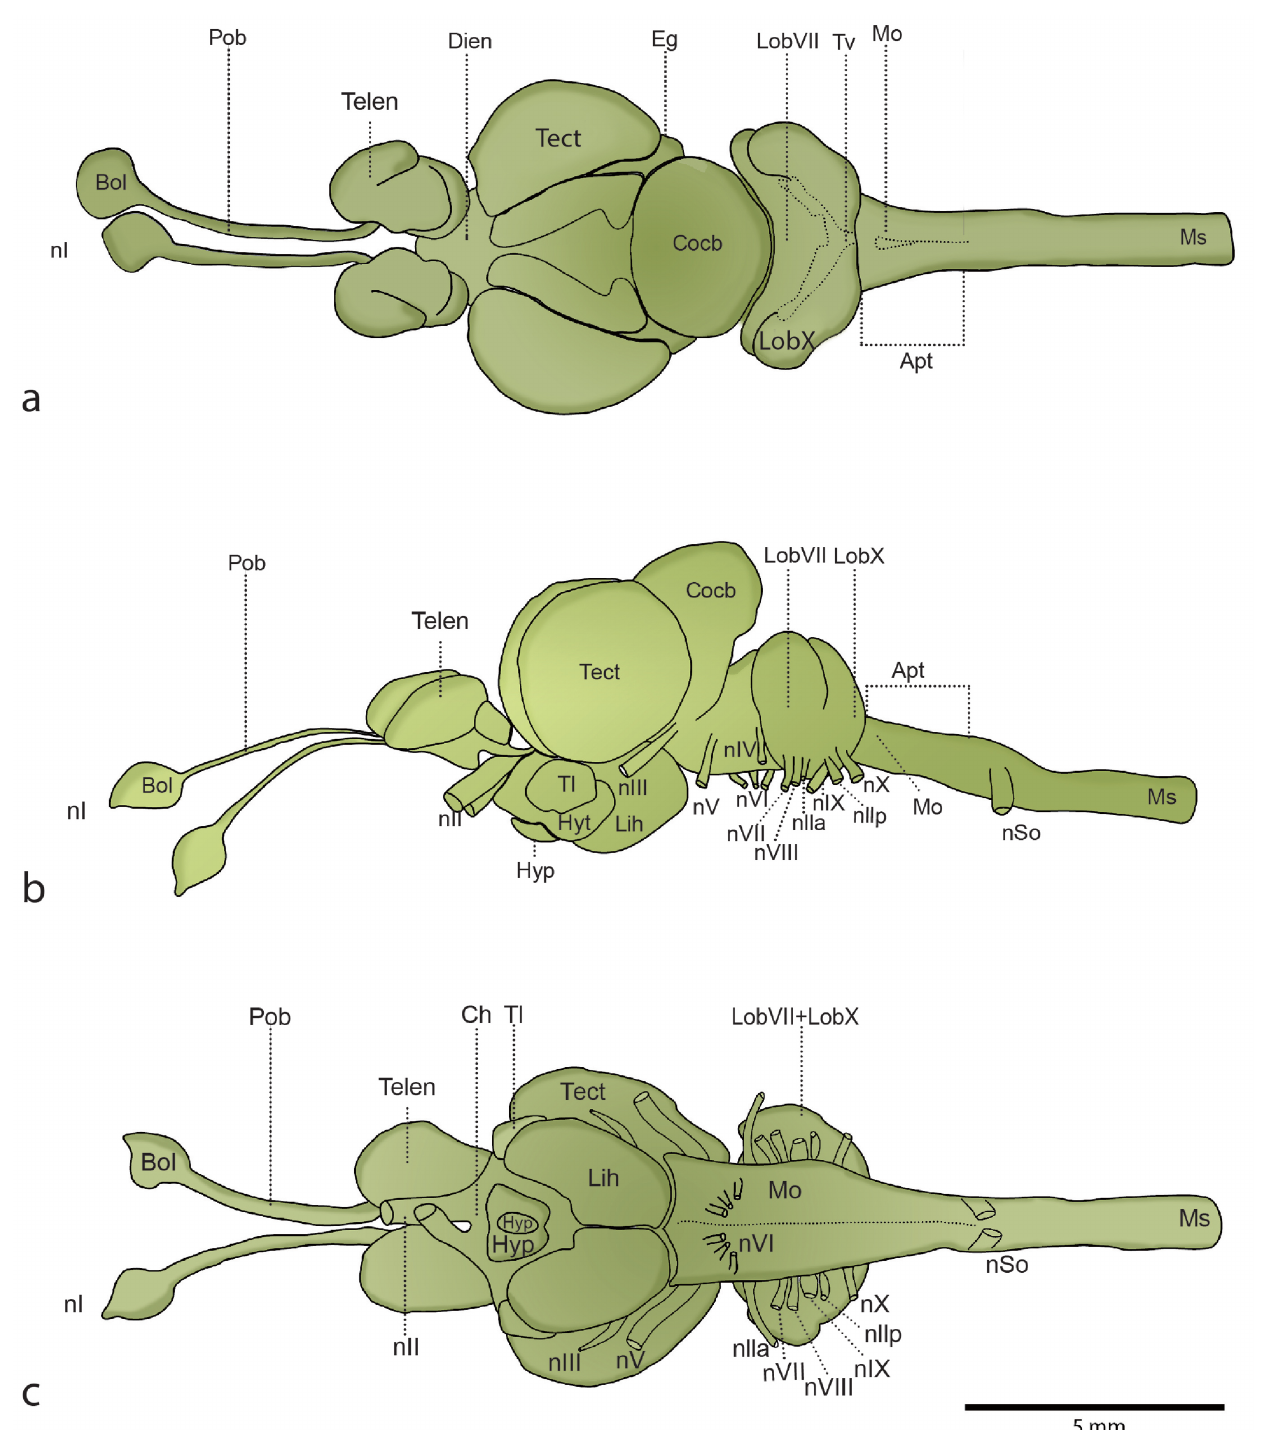
Fig. 3. Brain of Cyprinus carpio (Cypriniformes: Cyprinidae), LIRP 8923, 72.3 mm SL. a. dorsal; b. lateral and c. ventral views. Apt = Area postrema ; Bol = bulbus olfactorius ; Ch = chiasma opticum ; Cocb = corpus cerebelli ; Dien = diencephalon ; Eg = eminentia granularis ; Hyp = hypophysis ; Hyt = hypothalamus ; Lih = lobus inferior hypothalami ; LobVII = lobus facialis ; LobX = lobus vagi ; Mo = medulla oblongata ; Ms = medulla spinalis ; Pob = nervus tractus olfactorius ; Tect = tectum opticum ; Telen = Telencephalon ; Tl = Torus lateralis ; Tv = tela ventriculi . Cranial Nerves : nI = nervus olfactorius ; nII = nervus opticus ; nIII = nervus oculomotorius ; nIV = nervus trochlearis ; nV = nervus trigeminus ; nVI = nervus abducens ; nVII = nervus fascialis ; nVIII = nervus octavus ; nlla = nervus lineae lateralis anterior ; nllp = nervus lineae lateralis posterior ; nIX = nervus glossopharyngeus ; nX = nervus vagus and; nSo = nervus spino-occipitales